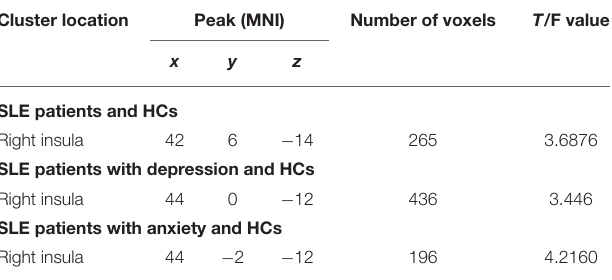
TABLE 4 | Regions with significantly different K trans value in SLE patients and HCs. Cluster